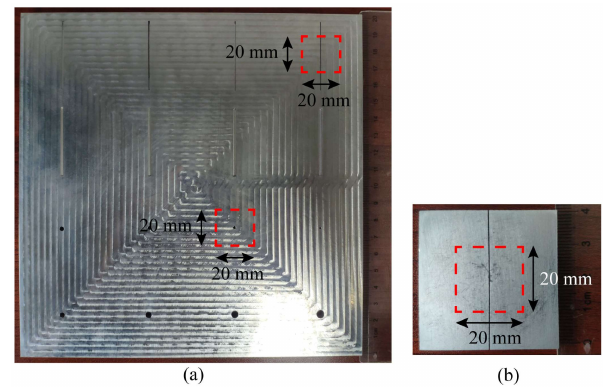
Figure 13. The pictures of metal boards, and the regions of red rectangles are to be imaged: ( a ) the aluminum board fabricated with cracks and vias; ( b ) the aluminum board etched with a 0.2 mm wide crack.